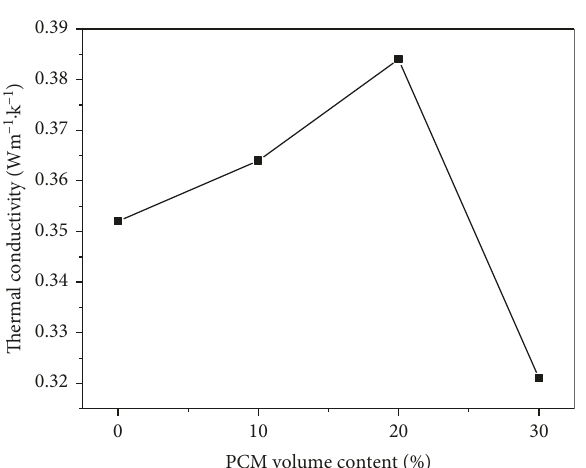
Figure 6: The center of the cubicle system temperature variation